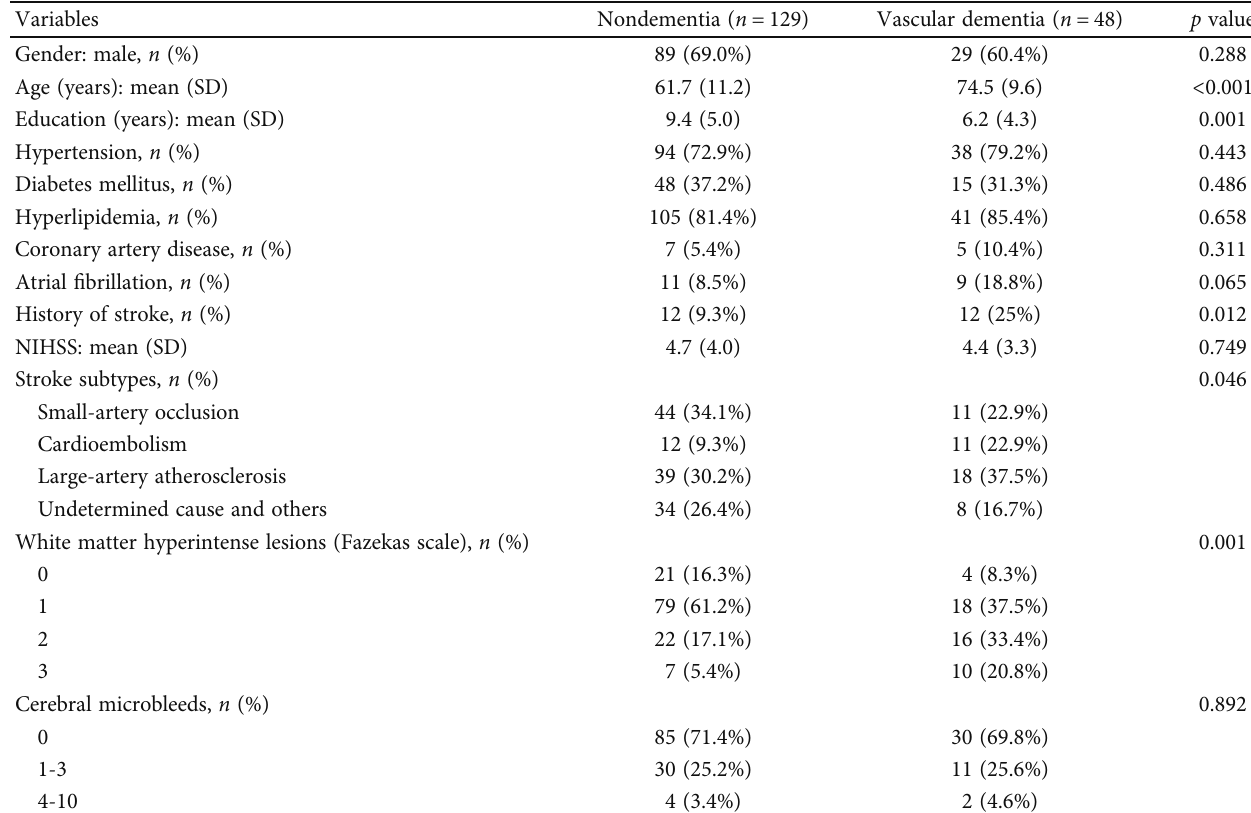
Table 1: Characteristics and univariable analysis of patients with vascular dementia vs. nondementia patients.